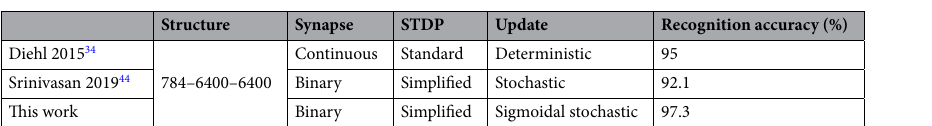
Table 1. Recognition accuracy of MNIST test images using a two-layer